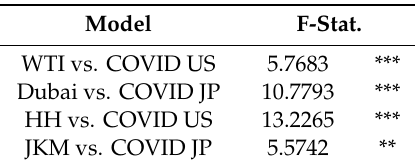
Table 6. Bounds F-test for cointegration.